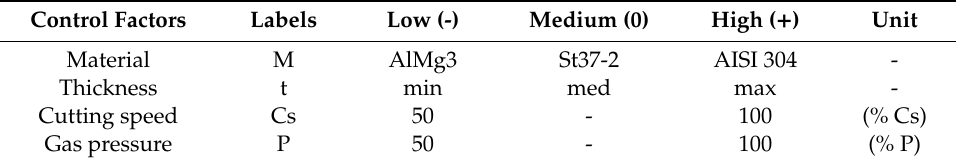
Table 5. Control factors and levels adopted in experimental tests.